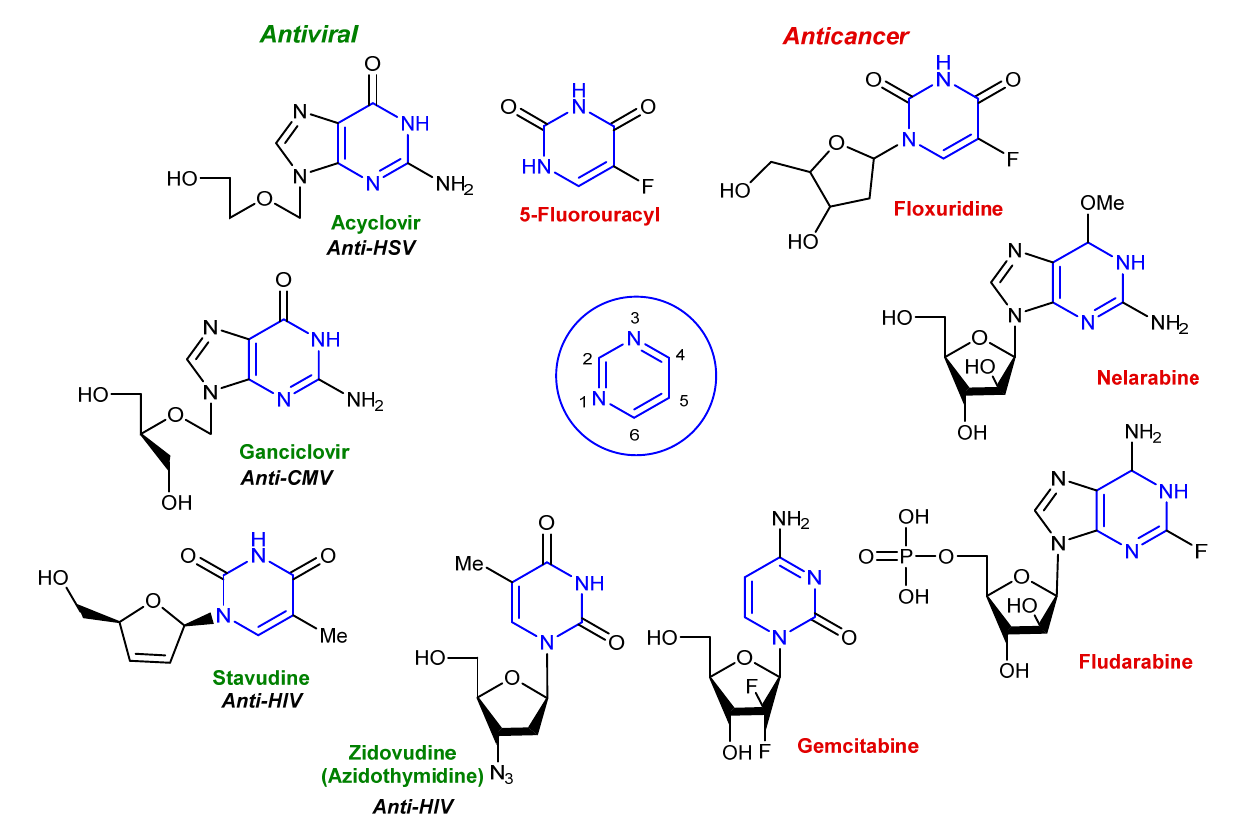
Figure 1. Structures of selected pyrimidine-based antiviral and anticancer agents.